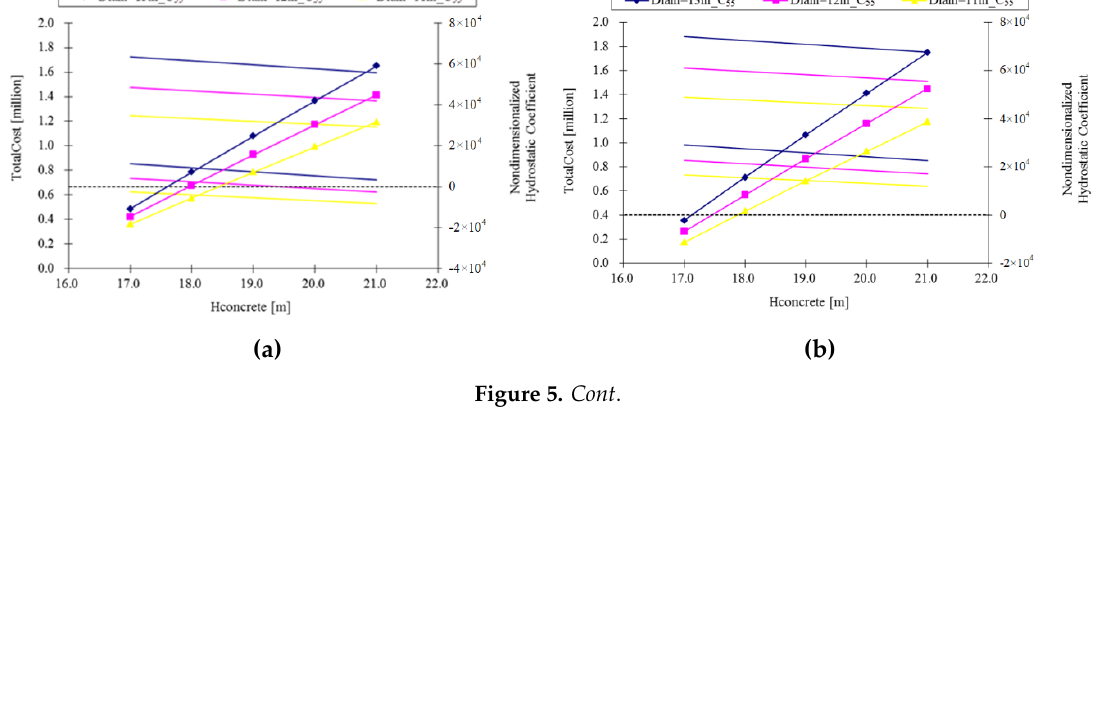
Figure 5. Hydrostatic stiffness and total cost for three cases: ( a ) platform steel wall thickness (SWT) = 0.015 m; ( b ) SWT = 0.0253 m; ( c ) SWT = 0.045 m. The solid line without a marker represents the upper and lower limits for the platform cost of the corresponding H concrete . The black dash line represents when hydrostatic coefficient equals 0. Based on the cost and tension discussed in Section 3, the design can be close to cost-optimized when it fulfills the design limits that steel mass/tether tension is in the range of approximately 0.02 to 0.04, while concrete mass/tether tension is in the range of 0.1 to 0.25. Figure 6 shows that the case